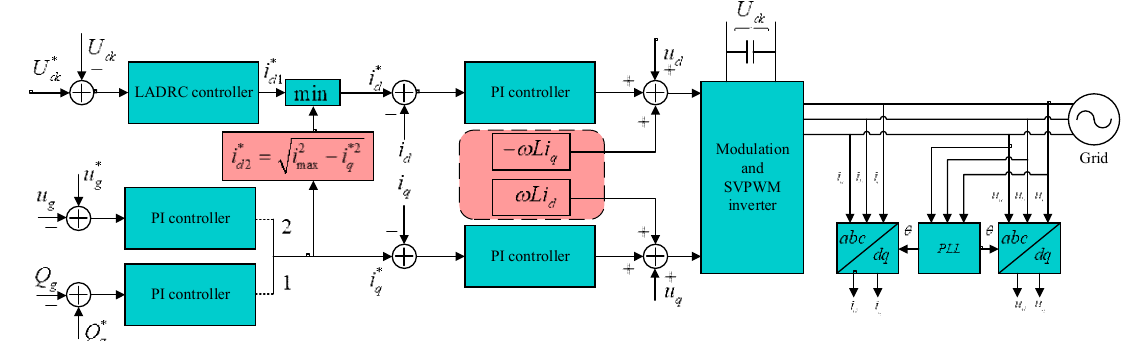
Figure 3. Control block diagram of the grid-side inverter with cross-decoupling and voltage feed-forward.